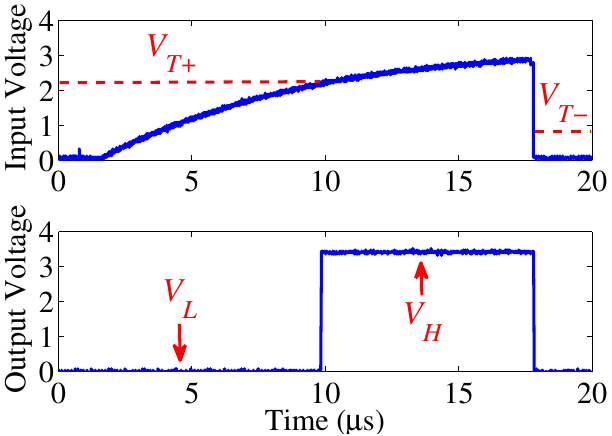
Figure 4. The input voltage is the distorted bus signal and the output is the standard I 2 C signal that the signal rising time is obviously less than 1 µ s.